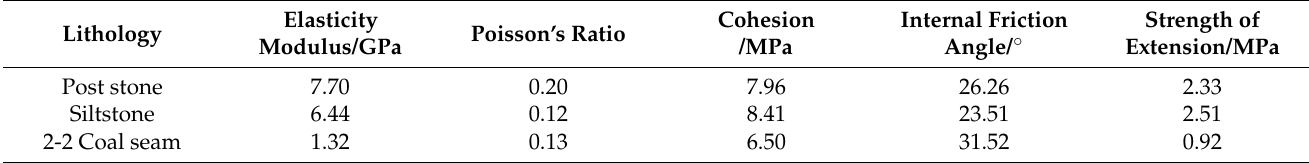
Figure 5. Numerical model. Table 2. Roof and floor strata around simulated entry and mechanical parameters. Table 2. Roof and floor strata around simulated entry and mechanical